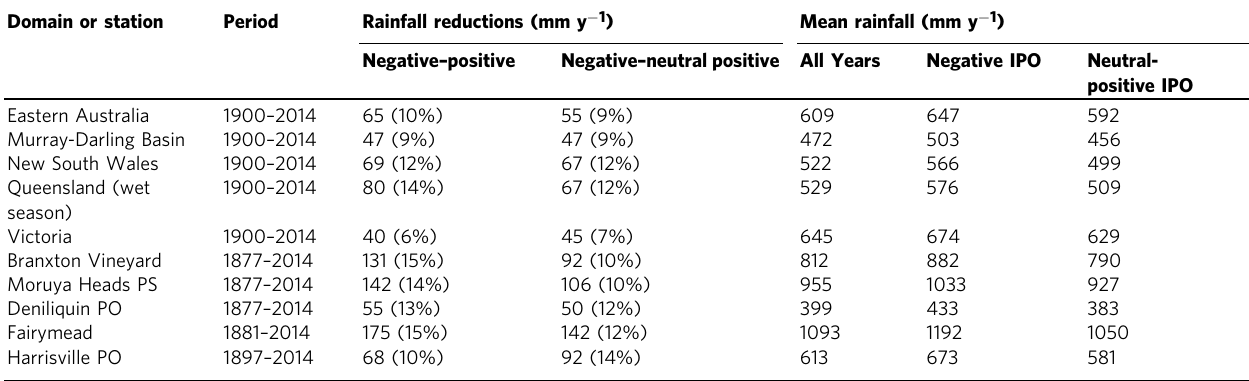
Table 2 Annual (calendar year) or wet season mean rainfall differences between IPO phases for eastern Australian domains and